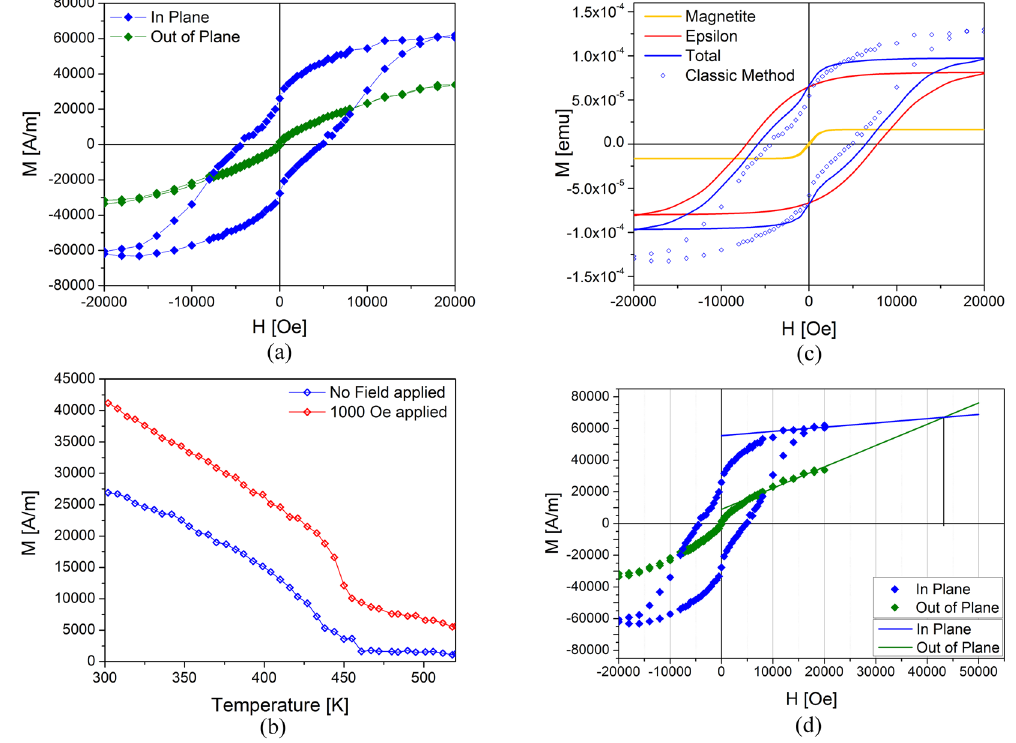
Figure 3. ( a ) Dependence of the magnetization of the ε -Fe 2 O 3 thin film with the applied magnetic field in the sample plane (blue symbols) and out of the sample plane (green symbols), showing the anisotropy of the sample. ( b ) Plot of M vs T measured under no field (blue) and under an applied magnetic field of 1000 Oe (red), showing how M does not vanish for temperature higher than the Curie temperature of ε -Fe 2 O 3 of 460 K when a small magnetic field is applied, thus revealing the presence of a soft phase with higher T C . ( c ) Experimental (blue symbols) and analytical (blue line) substrate corrected measurement, along with the two hysteresis loops corresponding to the separation of the epsilon ferrite (red) and magnetite (yellow) phase, respectively. ( d ) Estimation of the anisotropy field by comparing the in-plane and out-of-plane measured hysteresis